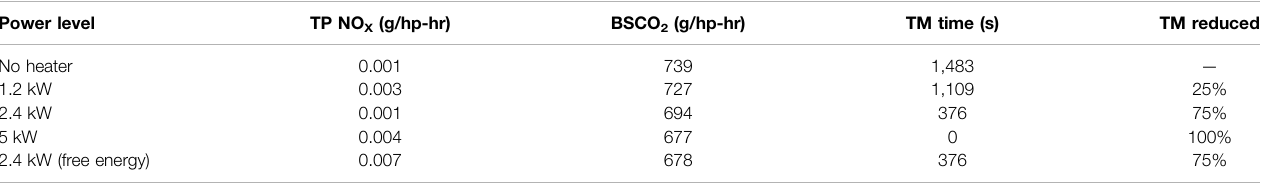
TABLE 11 | Beverage time in engine thermal management. Power level